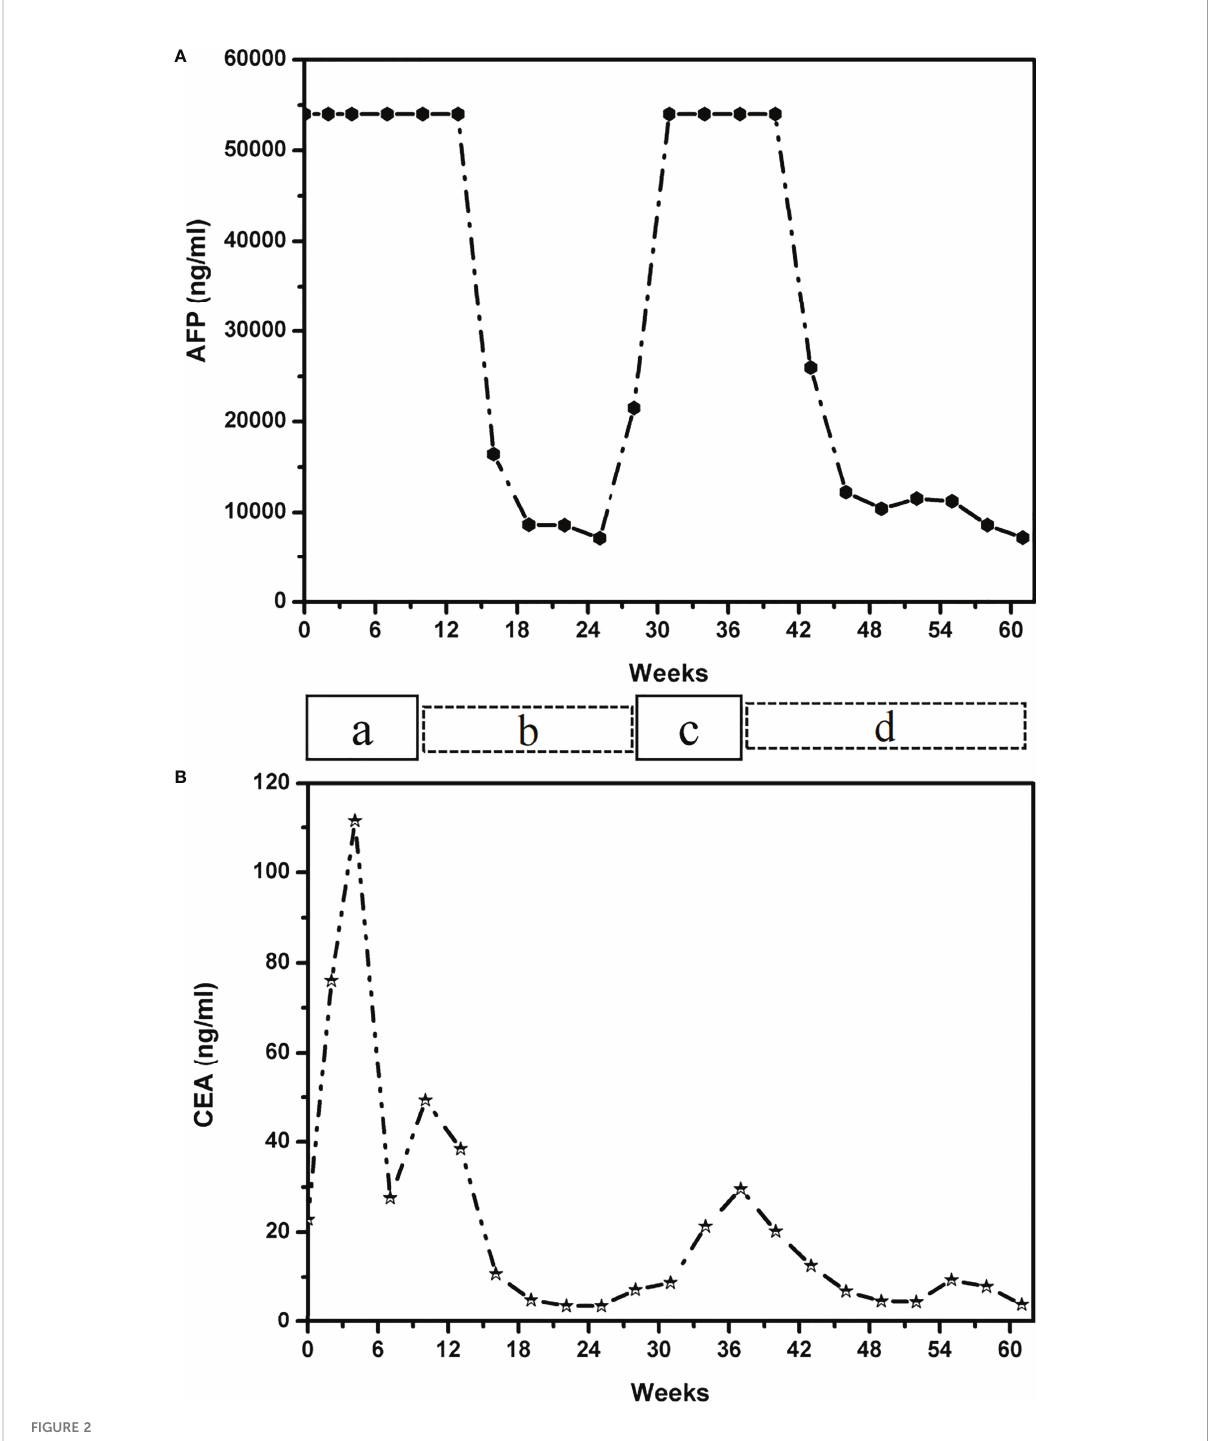
FIGURE 2 Graph depicting the patient ’ s therapeutic course and serum tumor marker of AFP levels (A) and CEA level (B) . The patient received the following treatments: a, paclitaxel liposome plus S-1 (tegafur/gimeracil/oteracil potassium); b, Tislelizumab combined with Oxaliplatin; c, Tislelizumab combined with Apatinib; d, Atezolizumab in combination with Irinotecan and Surufatinib capsules. AFP, alpha-fetoprotein; CEA, carcinoembryonic